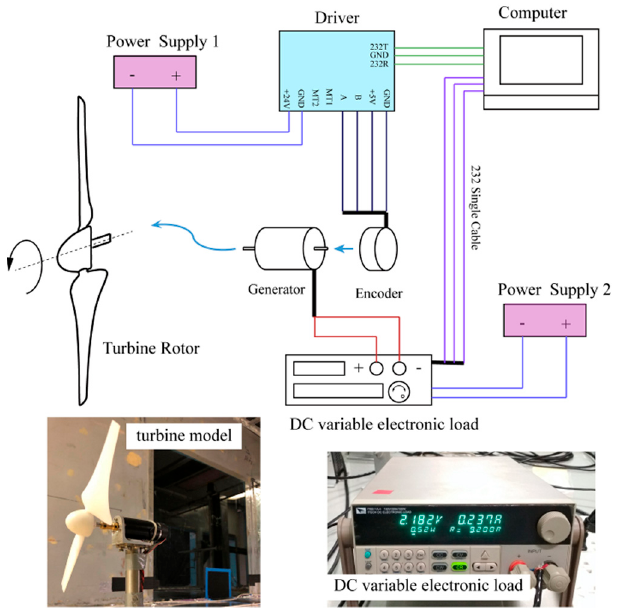
Figure 3. Photograph of the system of the passive driving mode (PDM) and power measurement.